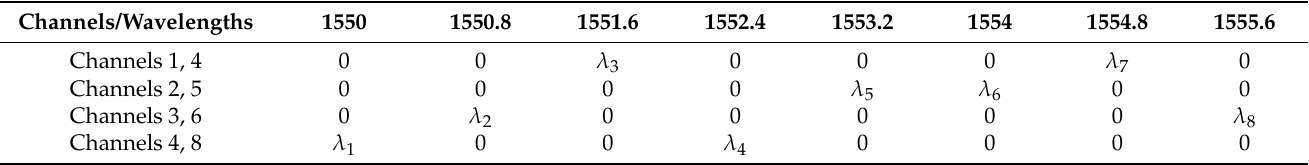
Table 1. Channels with their corresponding